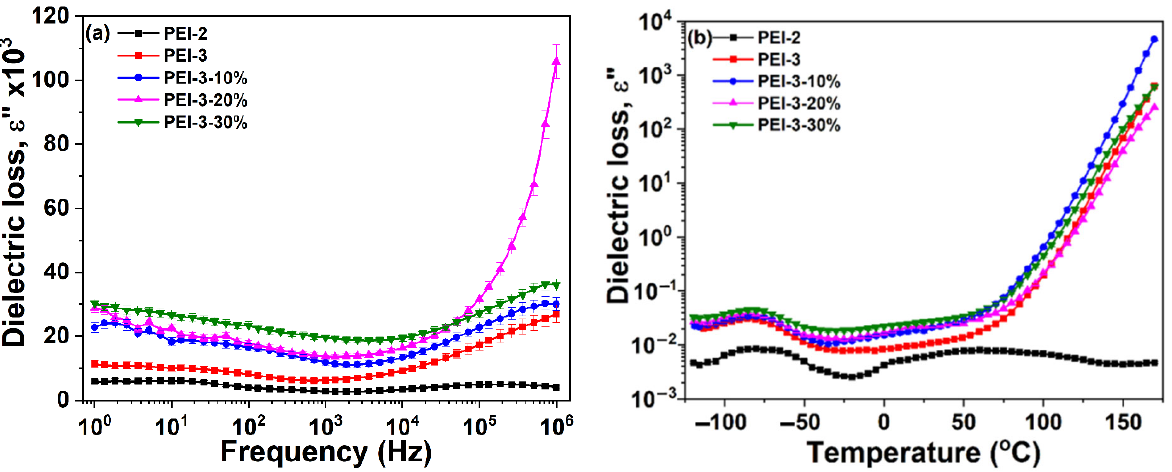
Figure 11. The evolution of dielectric loss with frequency at room temperature ( a ) and with temper ‐ ature at 10 Hz ( b ) for the studied materials.